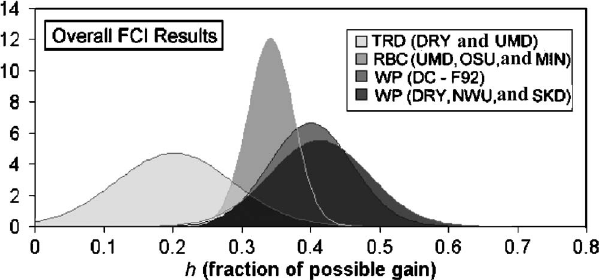
FIG. 1. Force concept inventory (cid:1) FCI (cid:2) results from nine schools with varying degrees of interactivity: traditional lecture classes (cid:1) TRD (cid:2) , lecture classes supplemented with research-based activities (cid:1) RBC (cid:2) , and Workshop Physics classes (cid:1) WP (cid:2) . (cid:1) From Ref. 70, used with permission.